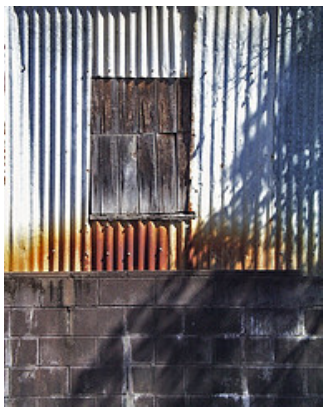
Figure 11: ‘Once was a Window’ by Shanrosen